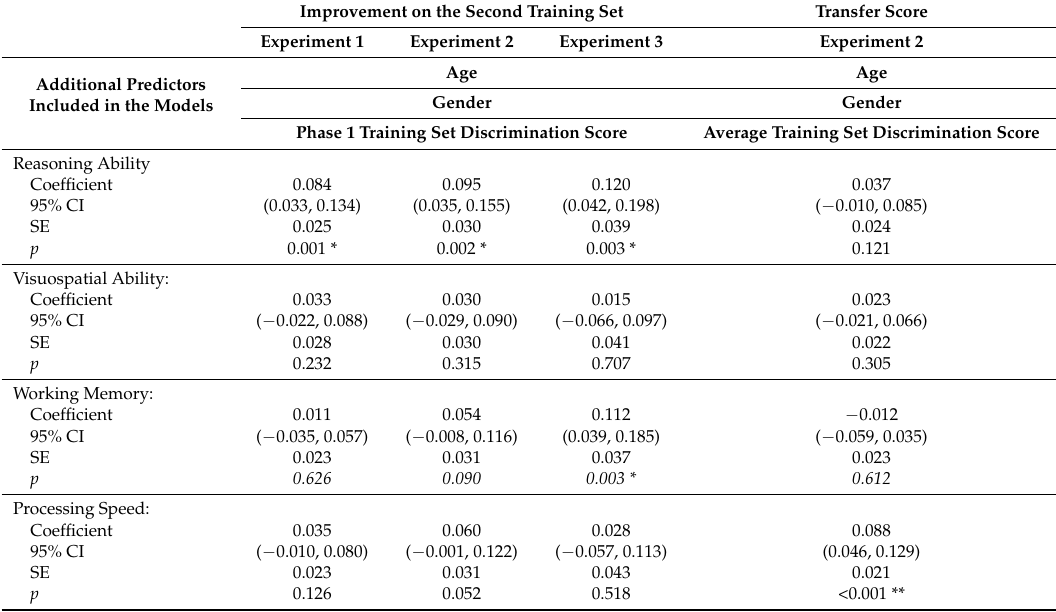
Table 5. Results of Linear Models That Regressed the Learning Measures on Each Fluid Ability and Controlled for Age, Gender and Training Performance 1